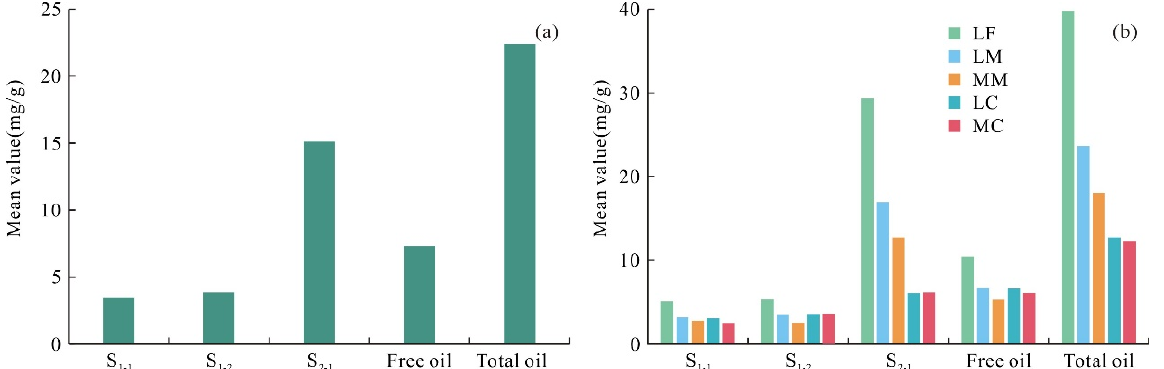
Figure 8. Content of shale oil in different occurrence states of the Ek 2 shales in the Cangdong Sag. ( a ) Histogram of S 1-1 , S 1-2 , S 2-1 , free oil, and total oil mean values. ( b ) Histogram of S 1-1 , S 1-2 , S 2-1 , free oil, and total oil mean values in different lithofacies. LF: laminated felsic shale; LM: laminated mixed shale; MM: massive mixed shale; LC: laminated carbonate shale; MC: massive carbonate shale.